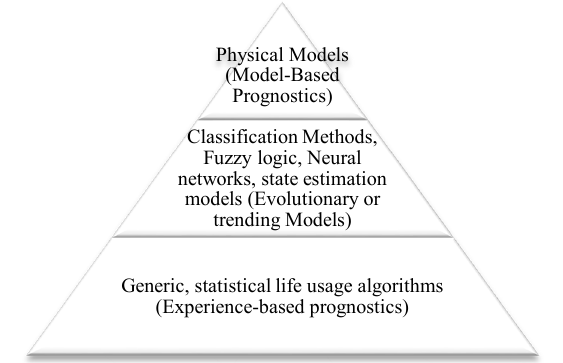
Figure 1. Hierarchy of Prognostics Techniques (adapted from Byington et al., 2002, pp.